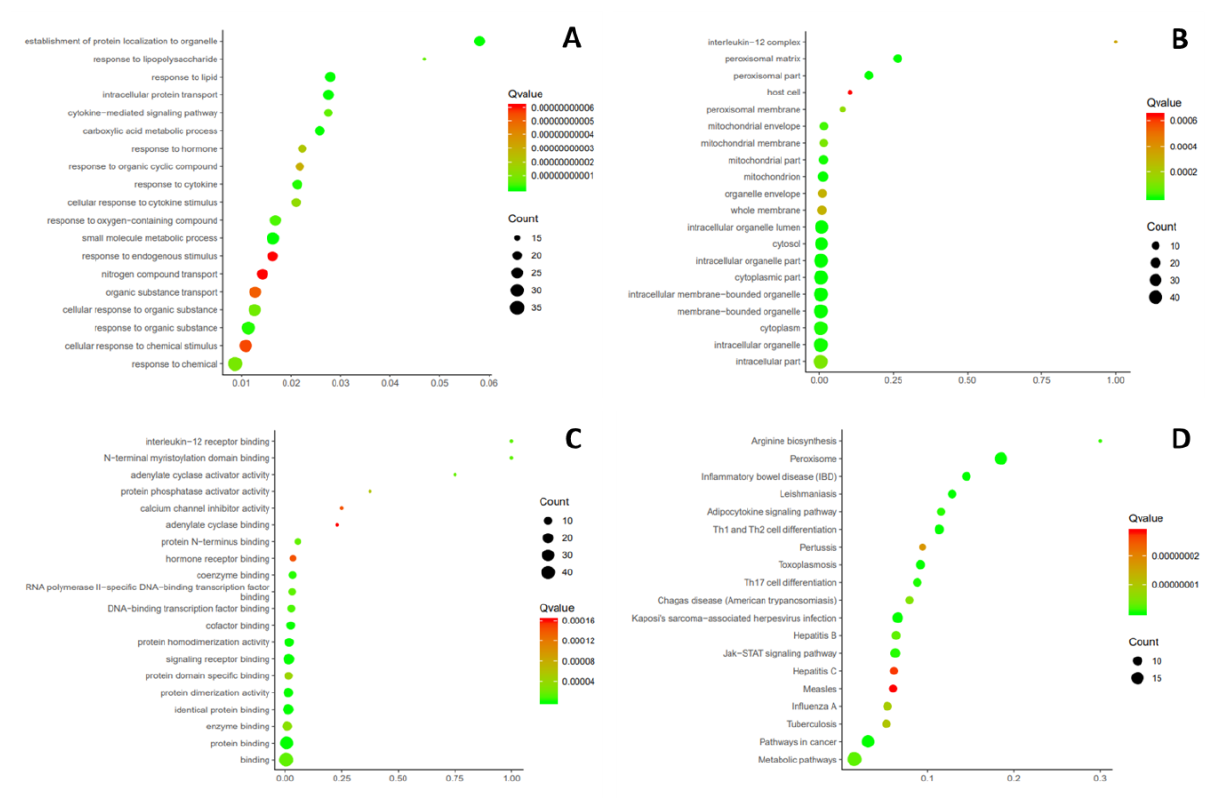
Figure 7: Plot of GO and KEGG pathway enrichment for iNOS/NOS2 and relevant genes (A: biological process enrichment; B:Cellular component enrichment; C:Molecular function enrichment; D:KEGG pathway enrichment).